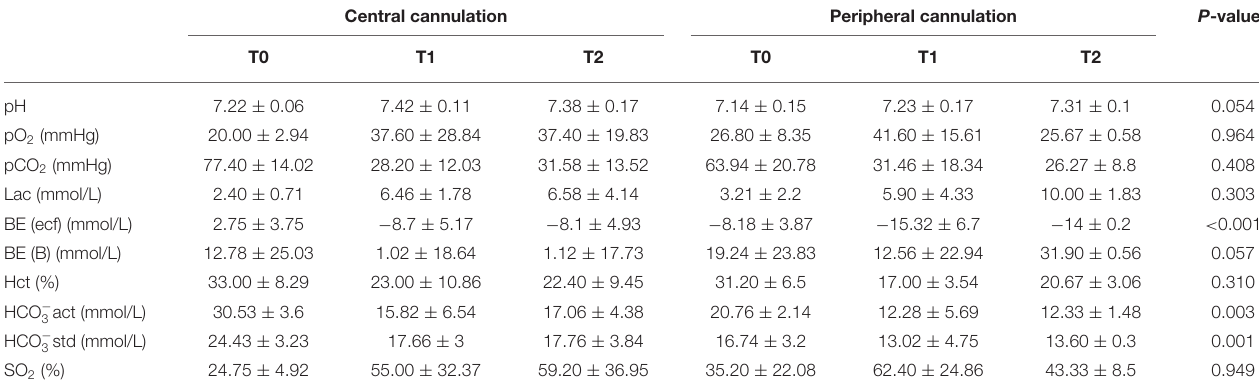
TABLE 5 | Blood gas